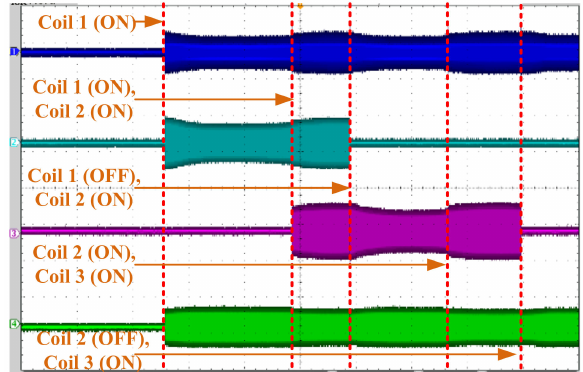
Figure 14. The experimental waveform variations during the process of the first load accessing. (CH1 (25 V/div): The output voltage of the inverter; CH2 (5 A/div): The currents through the first transmitting coil; CH3 (5 A/div): The currents through the second transmitting coil; CH4 (25 V/div): The voltage of the